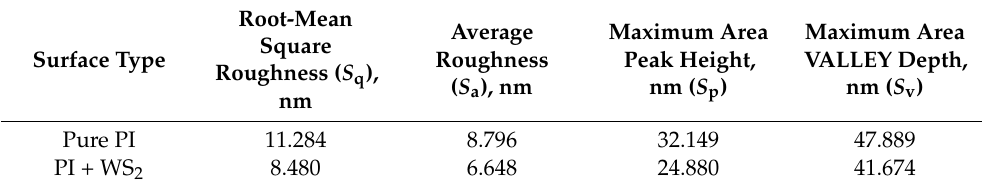
Table 2. Summary of the relief data for pure and WS 2 NTs-doped PI matrix.